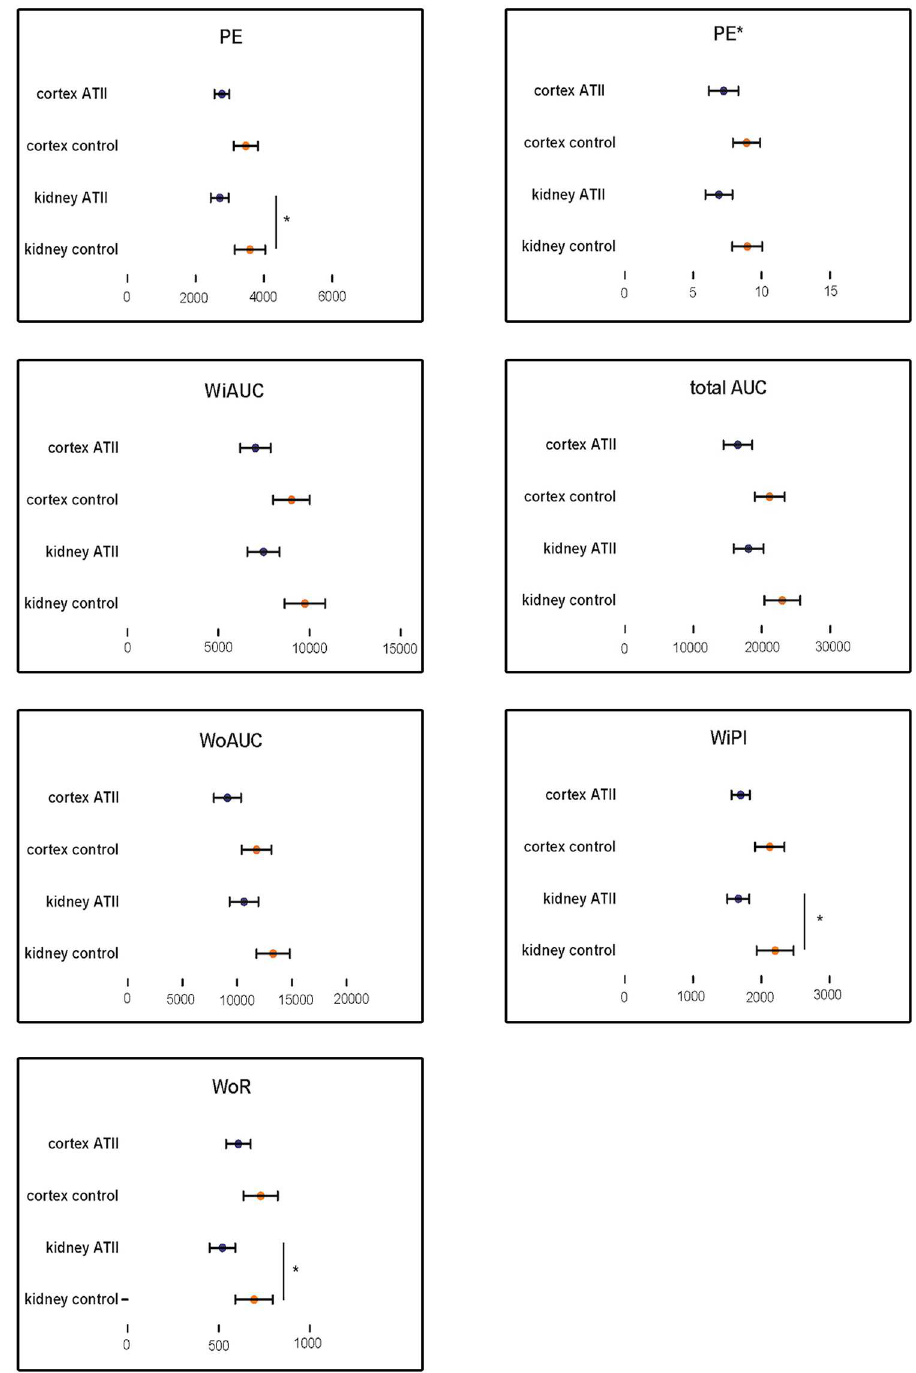
Fig 3. Changes in CEUS parameters induced by angiotensin II. presented as means +/- standard error. * p value < 0.05. From left to right, top to bottom: peak enhancement (PE), ratio of peak enhancement with interlobar artery (PE * ), wash-in area-under-the-curve (WiAUC), total area-under-the-curve (total AUC), wash-out area-under-the-curve (WoAUC), wash-in perfusion index (WiPI) and wash-out-rate (WoR). All parametersare expressed in arbitrary